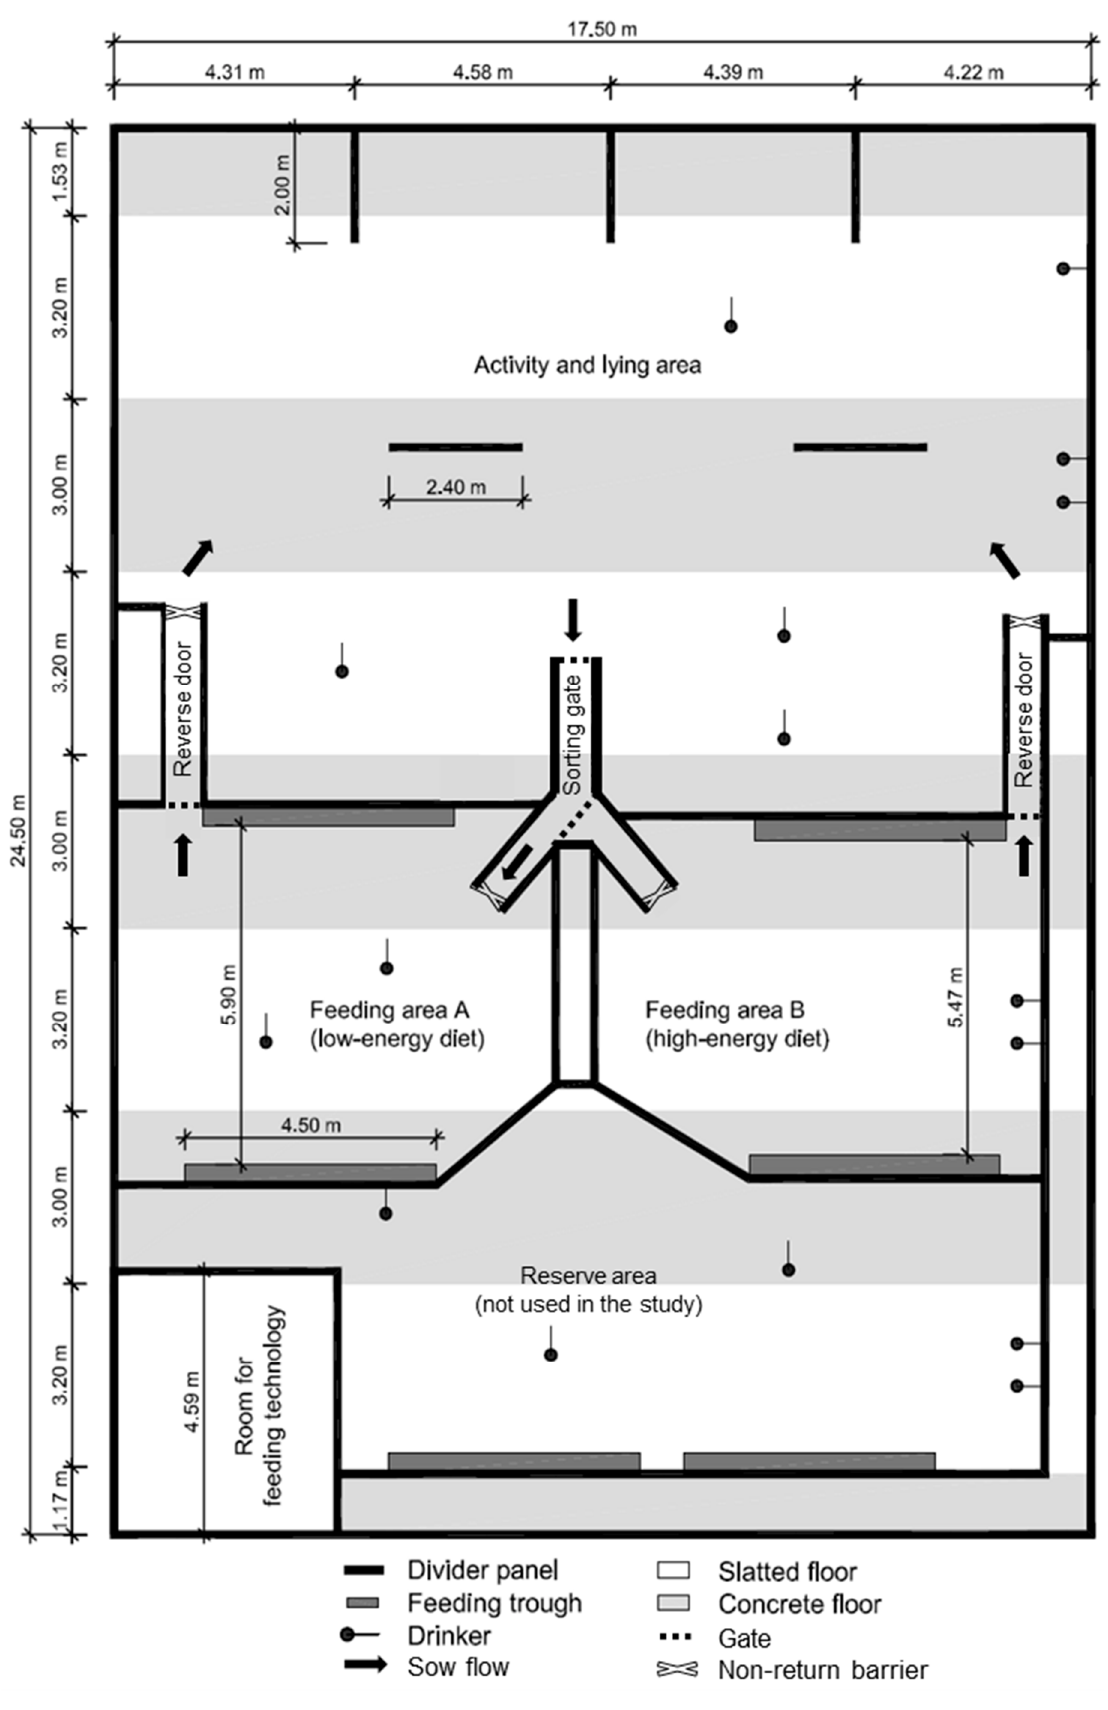
Figure 2. Floor plan of the Sow-Welfare-Optimized-Feeding system.